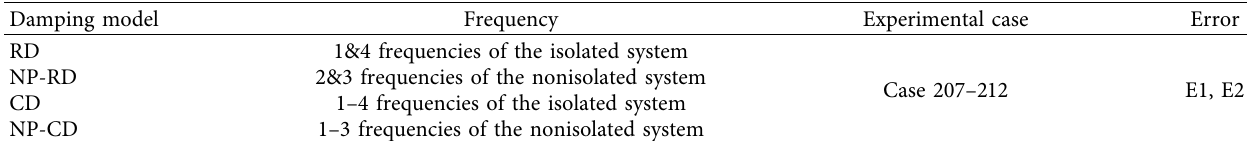
Table 9: Calculation schedule with PGA �